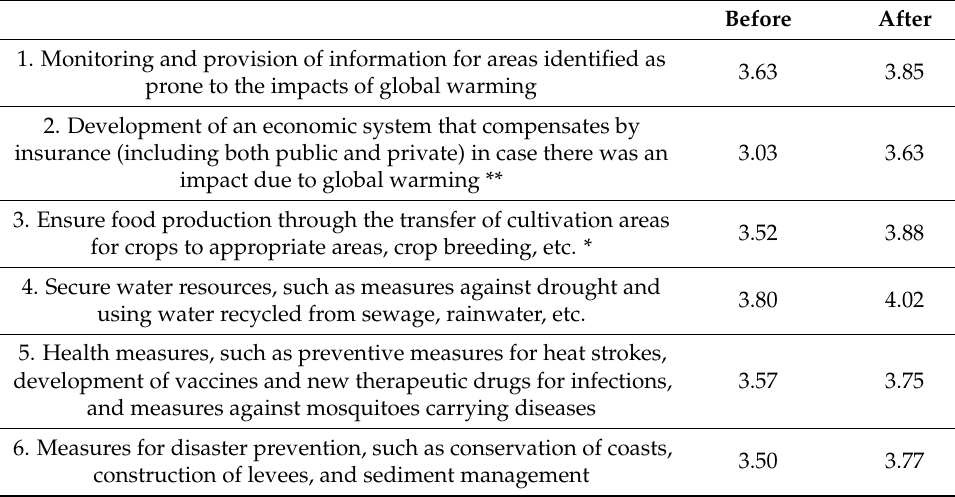
Table 6. Perceived effectiveness of climate change adaptation